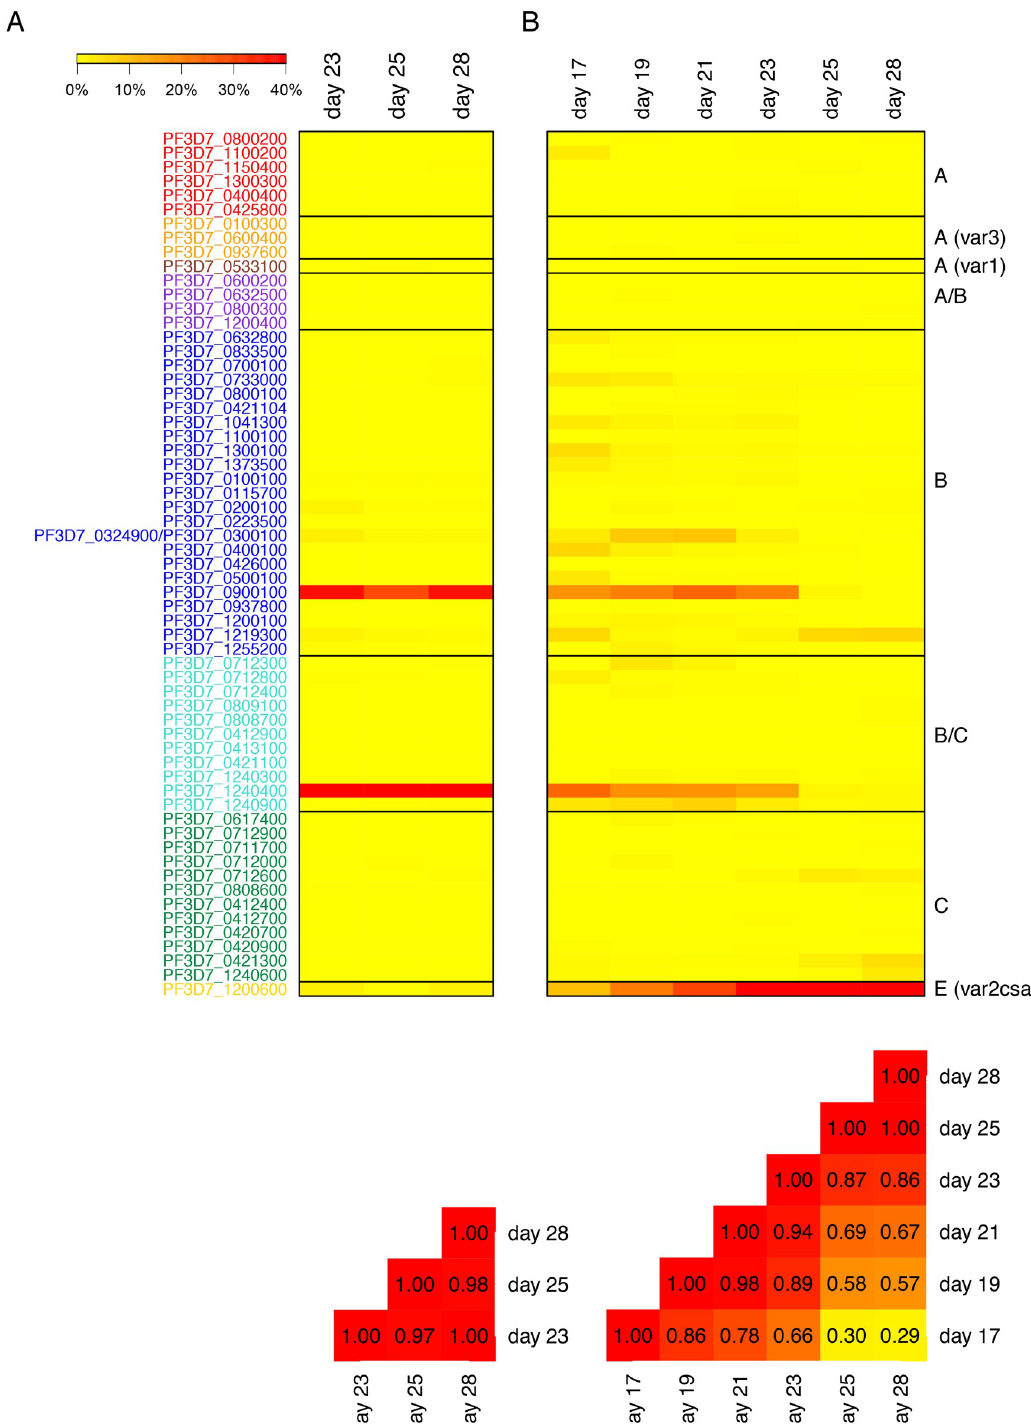
Fig 4. Var gene expression changes in vivo . (A, B) Monitoring of var gene expression over 3 or 6 parasite generations in volunteers L1-028 (A) and L1-026 (B) from the group of ‘controller’. Upper heat maps show the var transcript patterns of samples taken serially from volunteer L1-028 on day 13, 25 and 28 and from volunteer L1-026 on day 17, 19, 21, 23, 25 and 28 post infection. Lower heat maps present Spearman’s rank correlation coefficient ( ρ ) between the different samples. In all samples from L1-028 (A) the var transcript pattern was stable across the parasite replication cycles analyzed also indicated by the heat map showing the Spearman’s rank correlation coefficient between the different samples, which are all close to 1. For L1-026 (B) a major